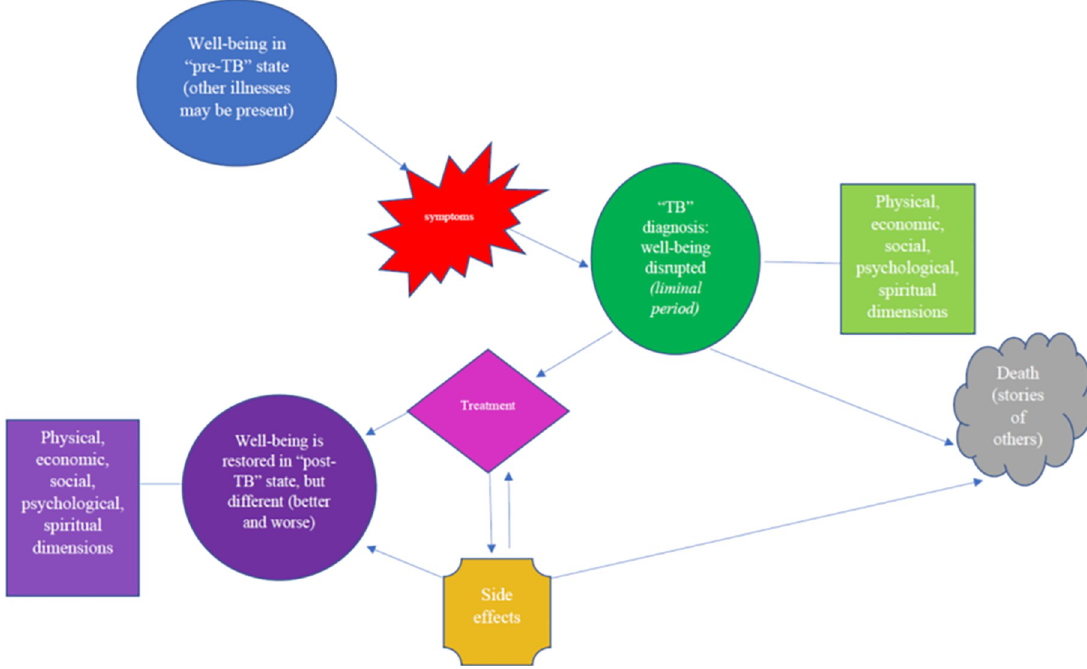
Fig 2. Enhanced analytic framework developed and utilized in this study.